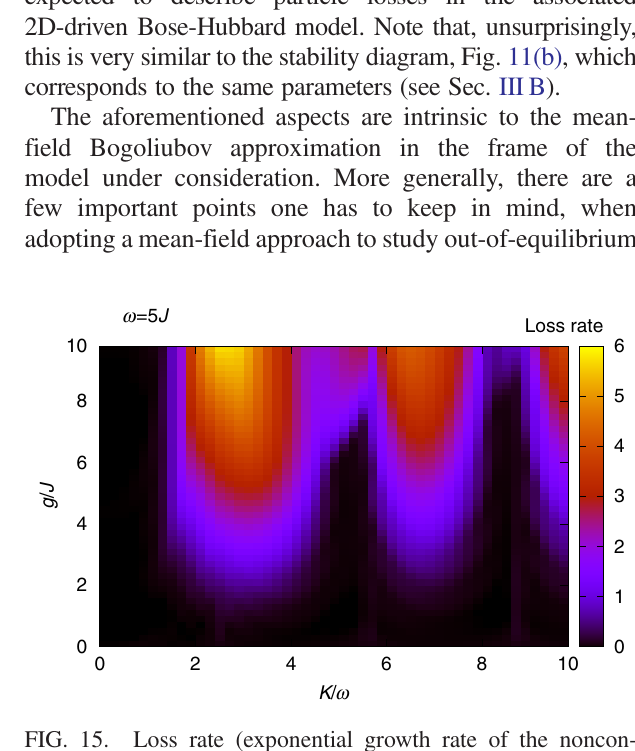
FIG. 15. Loss rate (exponential growth rate of the noncon- densed density) for the 2D lattice model of Sec. VI A, for ω ¼ 5 J 16 . This rate is obtained by fitting the exponential and N y ¼ growth of the noncondensed fraction, similarly to what was done in Fig. 5 for the